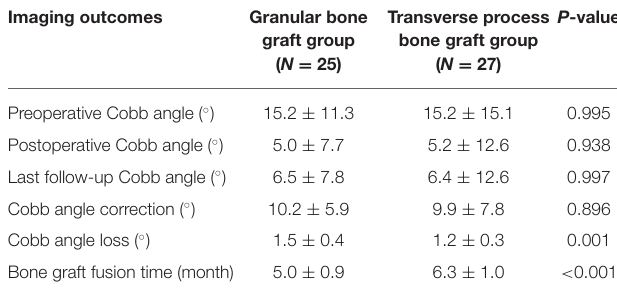
TABLE 3 | Comparison of imaging outcomes between the two groups.